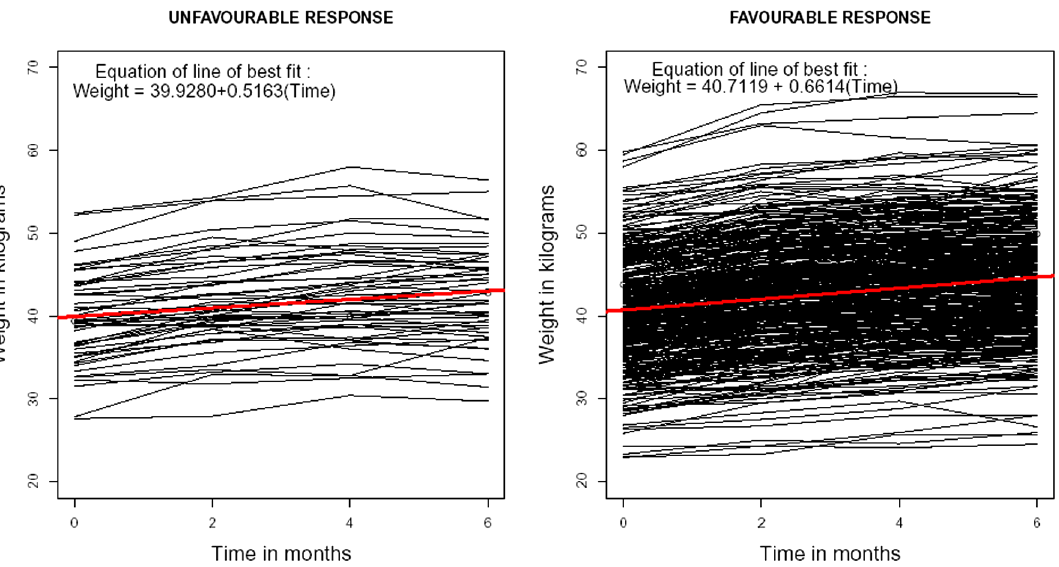
Figure 3. Scatter line diagram of weight of TB patients (in kilograms) versus time (in months) according to response status. Legend: Black lines - weight of TB patients. Red line - line of linear regression.